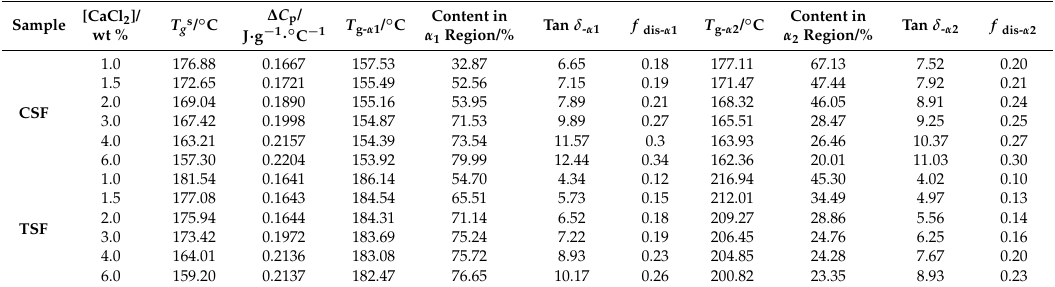
Table 5. SSDSC and DMA analysis of CSF and TSF samples in their glass transition region [30] *. Sample [CaCl 2 ]/ wt